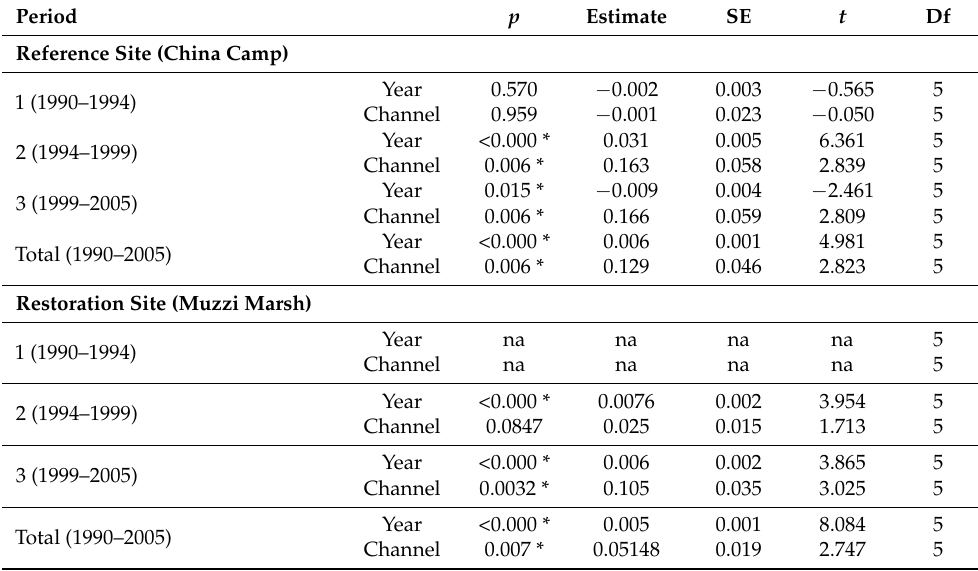
Table A2. Sub-dominant plant species abundance change over time. At the reference site, abundance significantly increases during period 2 (low salinity) and subsequently significantly decreases when salinity rises in period 3. At the restoration site, sub-dominant species are not present in period 1 and increase significantly during periods 2 and 3. At both sites, change in sub-dominant cover is increased in plots containing channels. * connotes significant results.